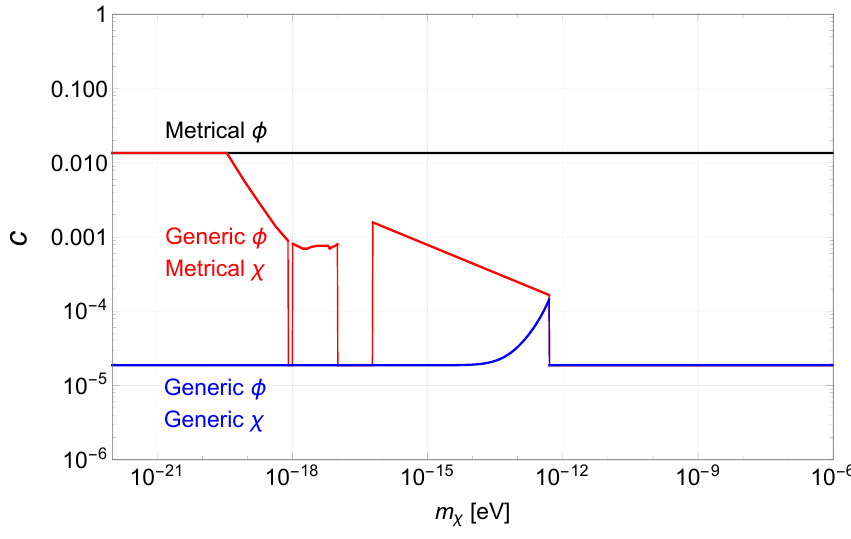
Figure 2 . The re(cid:12)ned upper bound on the parameter c as a function of the mass m (cid:31) of a modulus- like scalar (cid:12)eld (cid:31) introduced to relax the original bounds (3.12) and (3.13). This shows that the original bounds are not signi(cid:12)cantly relaxed by additional light scalar once the observational constraints on such light scalar are properly taken into